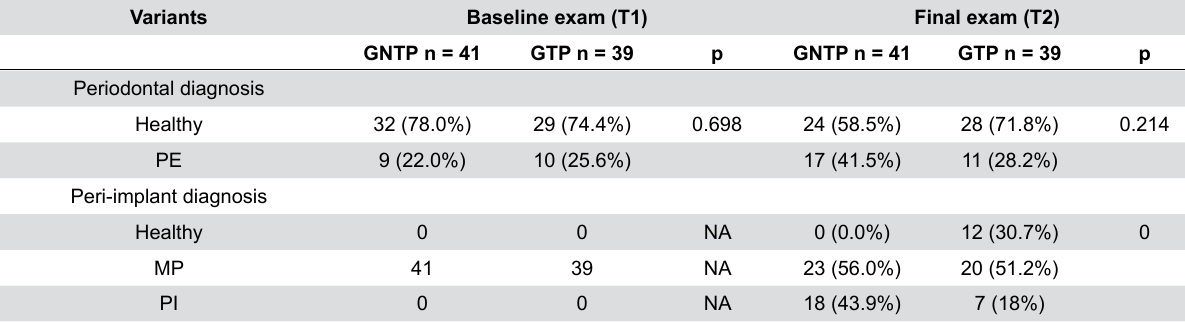
Table 1- Sample characteristics